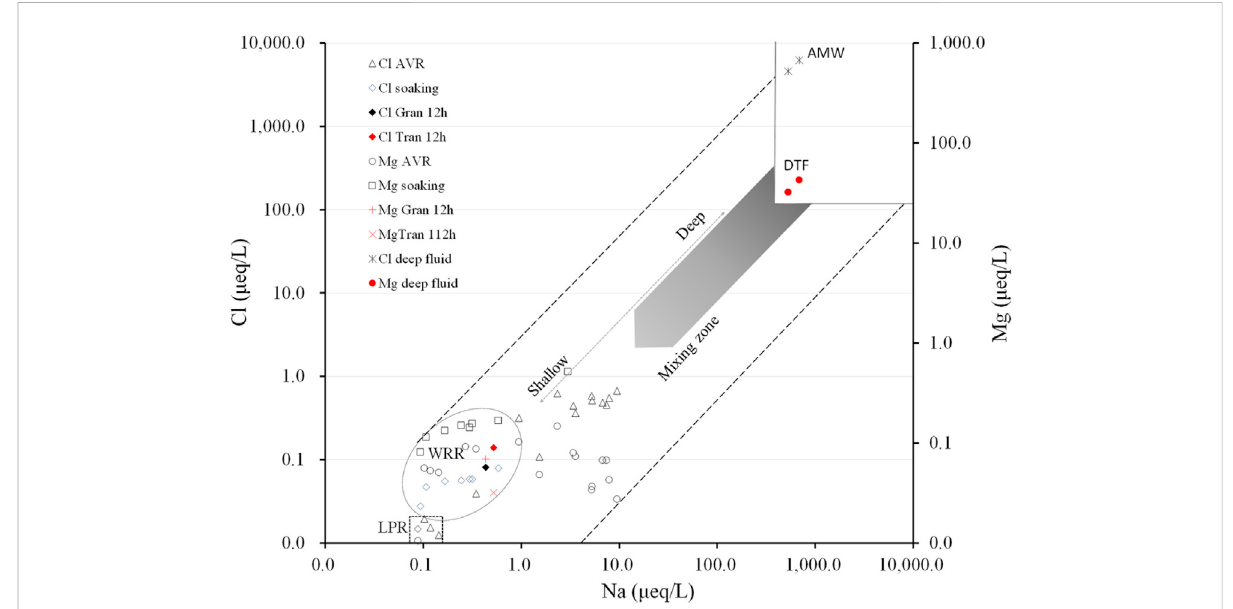
FIGURE 4 Source partitioning of Na – Mg – Cl ions in the AVR waters; data of deep-earth fl uid after Amita et al. (2005); Cl AVR and Mg AVR are in this study; others (solutions of soaking granodiorite and trachyandesite) are after Du et al. (2010); LPR is the local precipitation region (rectangle); WRR is the water – rock reaction region (oval); DTR is the deep-earth fl uid region; AMW displays approximately andesitic-magmatic water.